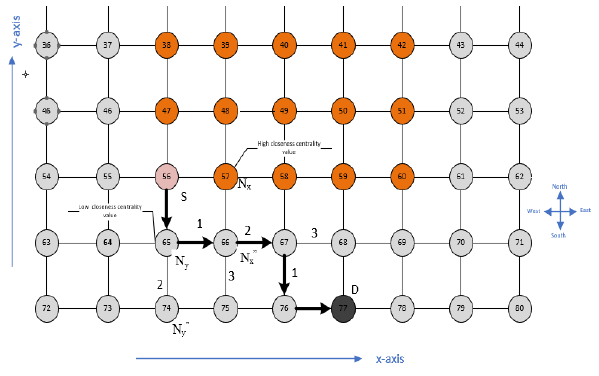
Fig. 9. Example Explaining algorithm 2, Based on